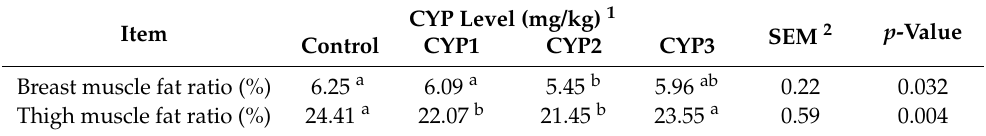
Table 3. Effects of CYP on IMF content from breast and thigh muscles in broilers.